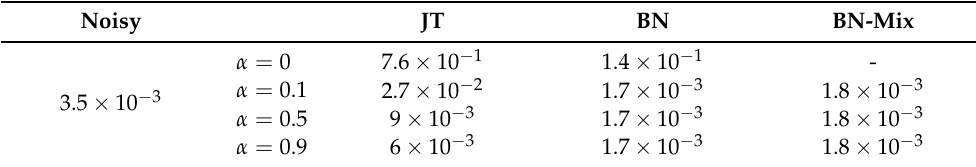
Table 5. The MSE metric for different architectures with different α